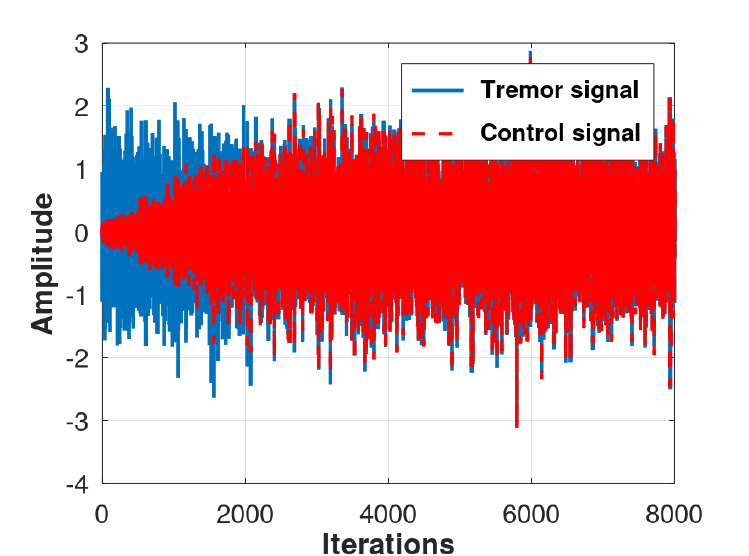
Figure 8. Control evaluation results produced by the Fx-NLMS algorithm for 30 runs of a Monte Carlo simulation.